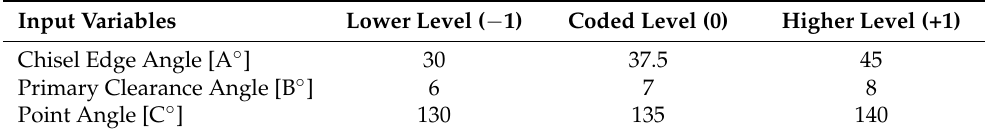
Figure 7. Example of hole circularity measurement of CFRP panel. Table 3. The parameters selected for RSM investigation along with their coding